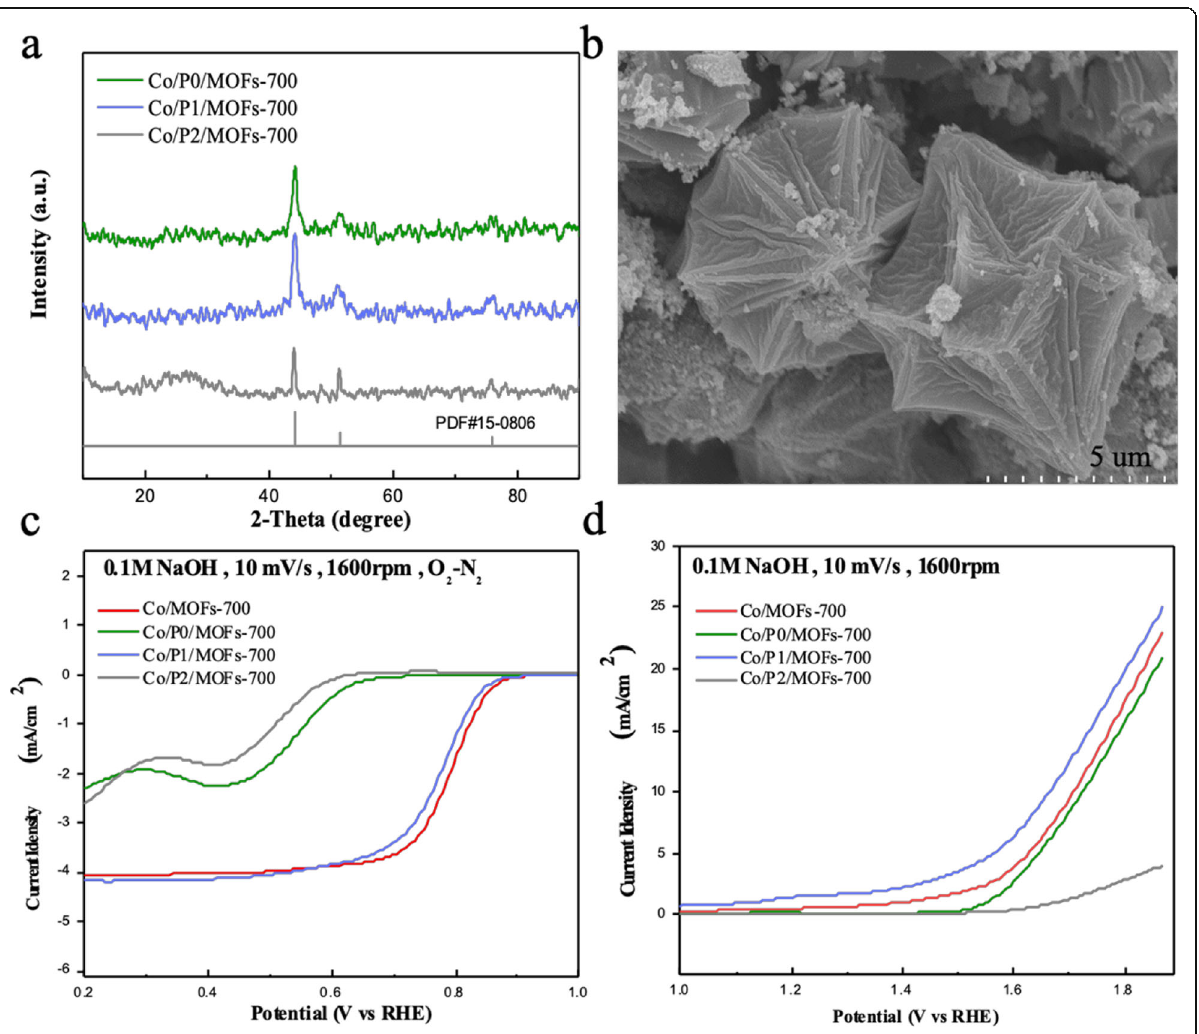
Fig. 2 a XRD pattern of Co/P0/MOFs-700, Co/P1/MOFs-700, and Co/P2/MOFs-700. b SEM images of Co/P1/MOFs-700. c ORR polarization curves of the phosphorus-doped samples. d OER polarization curves of phosphorus-doped